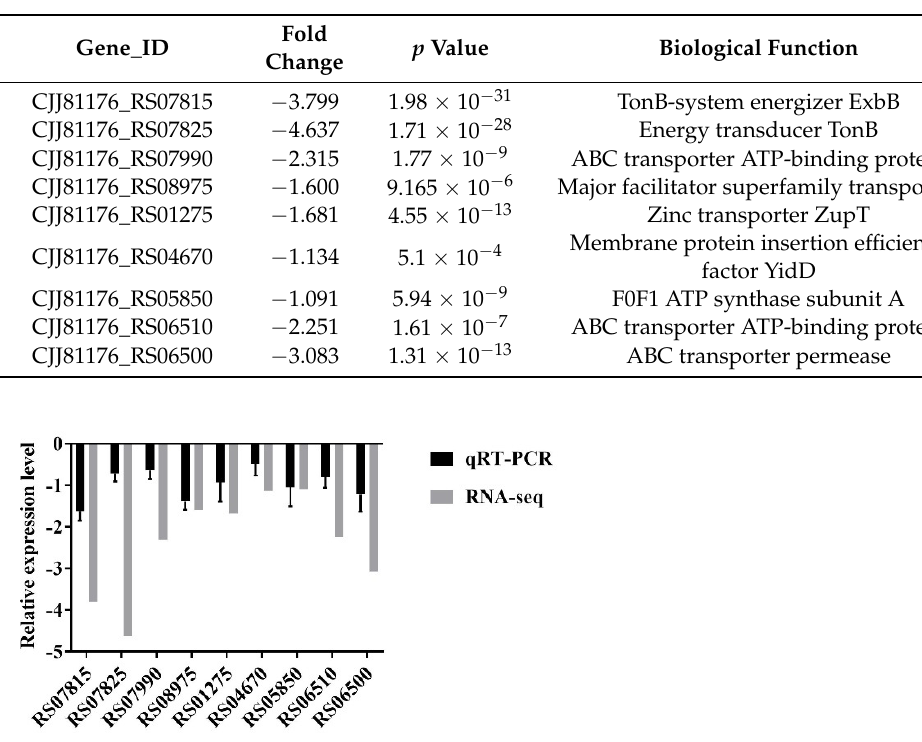
Table 2. Transcription intensity changes of open reading frames of C. jejuni 81-176 treated with 16 µ g/mL DATS.